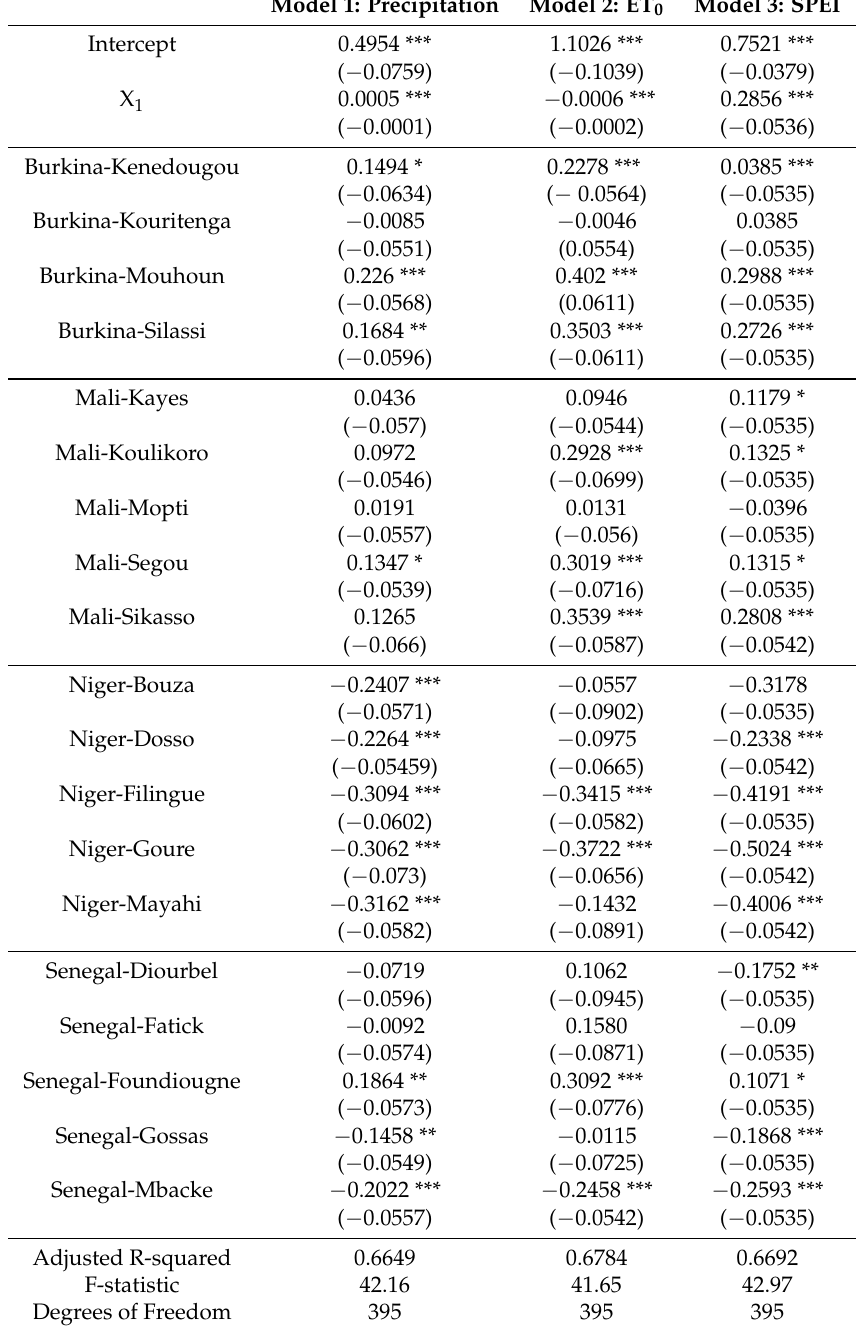
Table 1. Regressions Predicting Yield Numbers within the brackets () represent the standard error of the estimate directly above themselves. Different p -values are used to determine significance—* represents estimates that p -values smaller than 0.05, ** represent estimates that have p -values smaller than 0.01, and *** represent estimates that have p -values smaller than